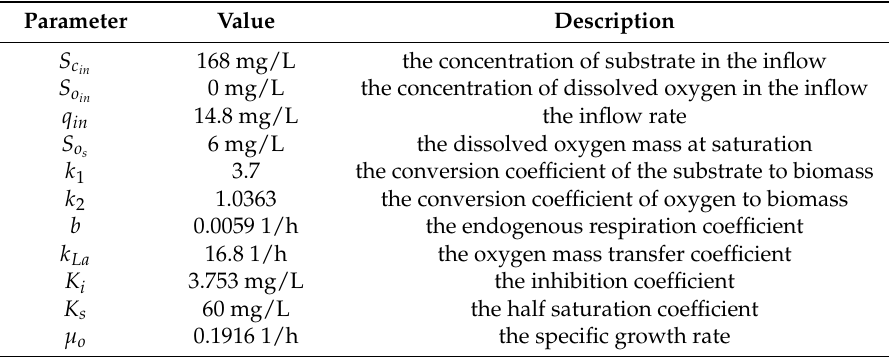
Table 1. Model parameters for the wastewater treatment